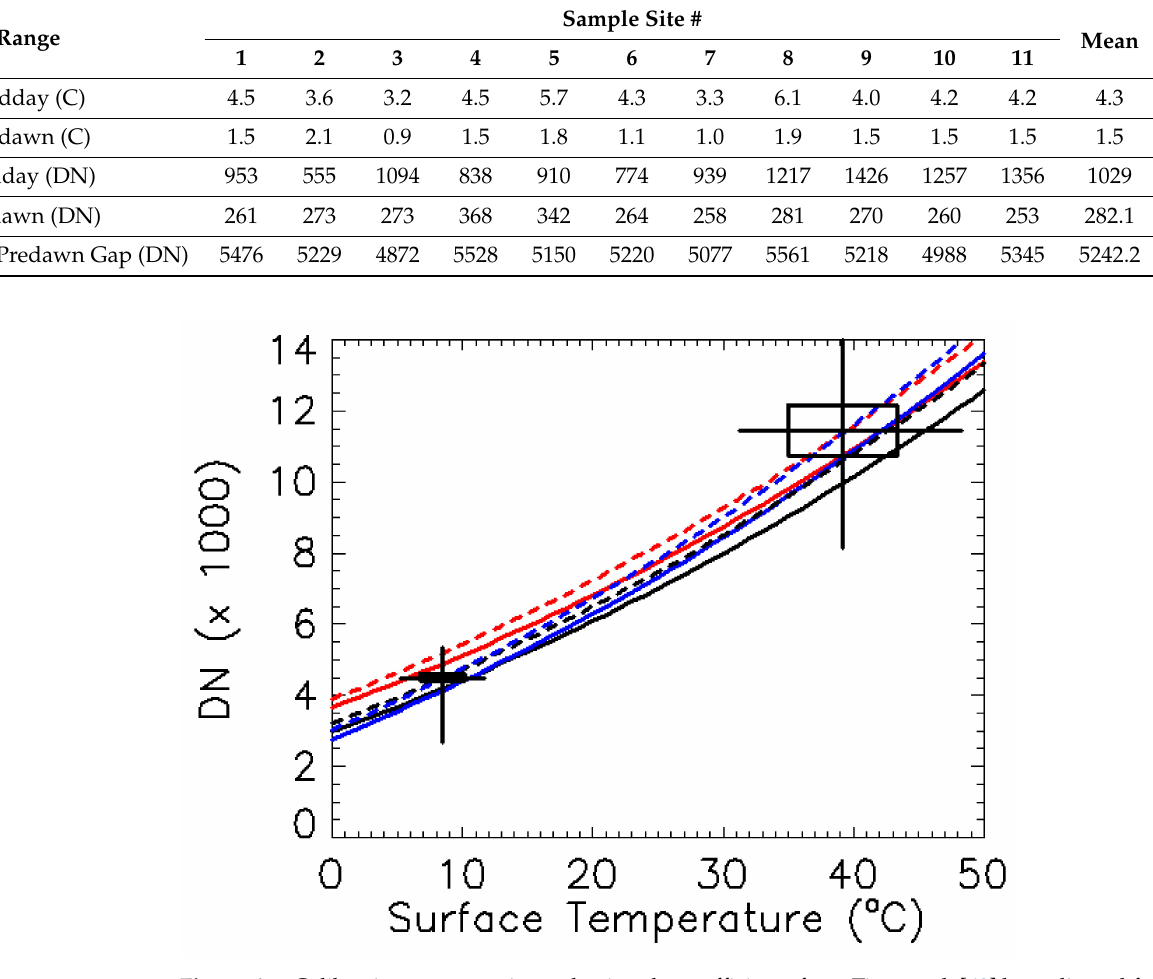
Figure A1. Calibration curves estimated using the coefficients from Titus et al. [69] but adjusted for the Pisgah 2011 dataset. Red, blue, and black curves are based on the calibration coefficients